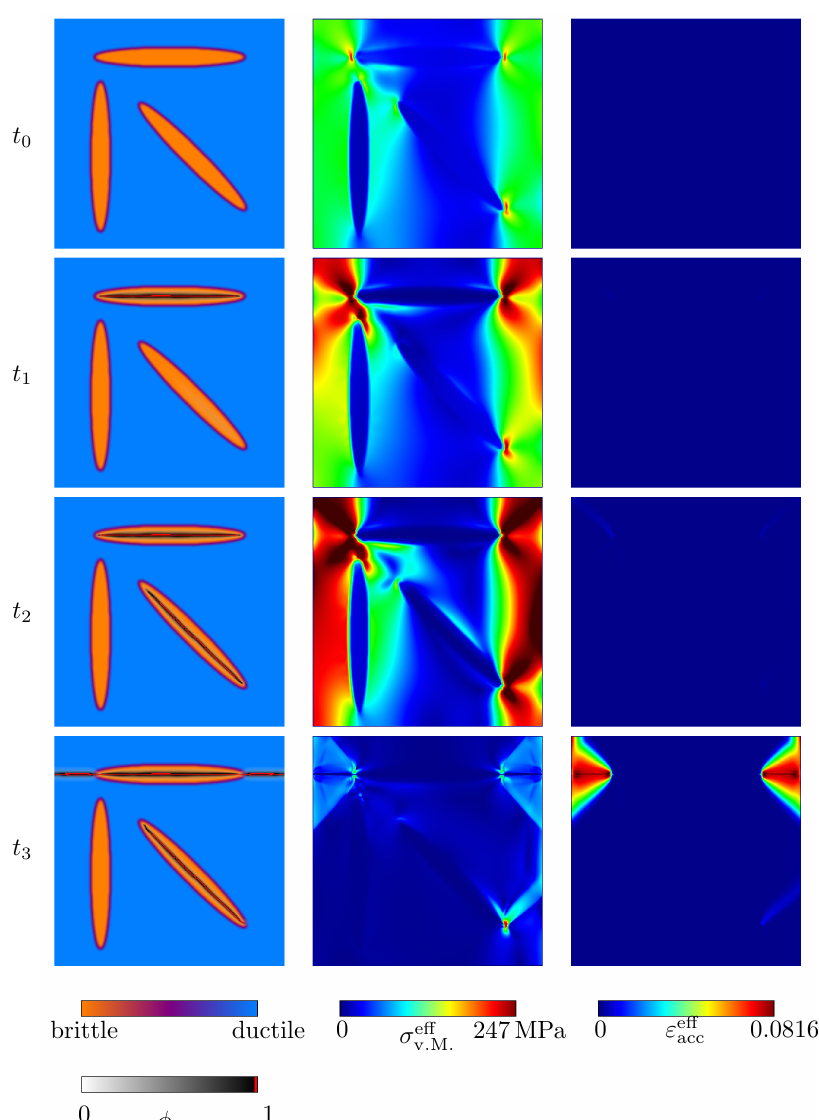
Figure 10. Evolution of the crack phase field φ c (first column) and the resulting von Mises stresses σ eff (second column), together with the effective accumulated plastic strain ε eff acc (third v.M. column) of an idealised grey cast iron microstructure. Uniaxial tensile load was applied. The corresponding macroscopic uniaxial strain states are given in Figure